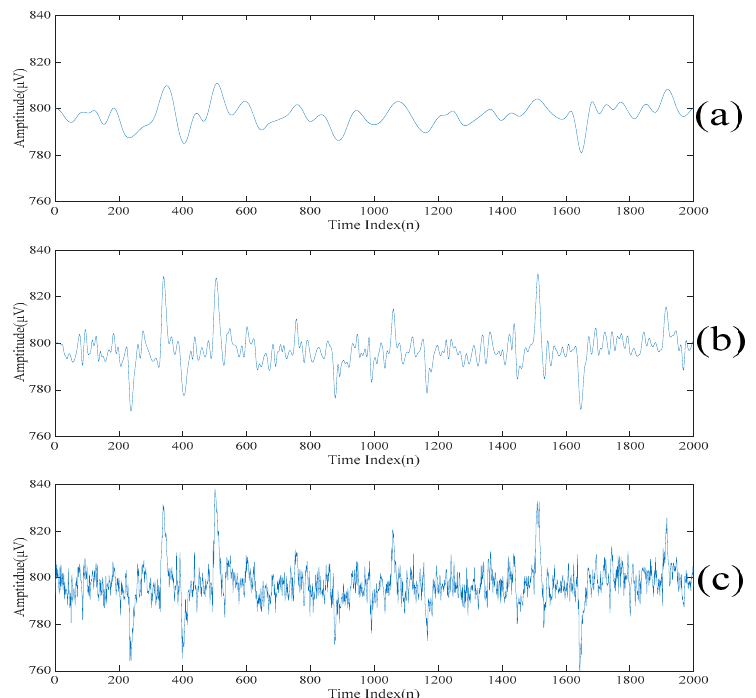
Figure 13. ( a ) The despiked electroencephalogram in the time domain reconstructed using the last five intrinsic mode functions. ( b ) The despiked electroencephalogram in the time domain reconstructed using the last seven intrinsic mode functions. ( c ) The despiked electroencephalogram in the time domain reconstructed using the last nine intrinsic mode functions.